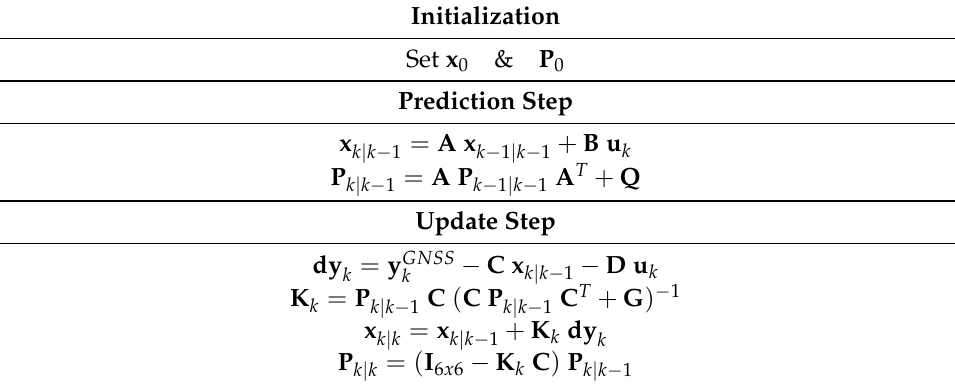
Table 3. The Kalman filter (KF)